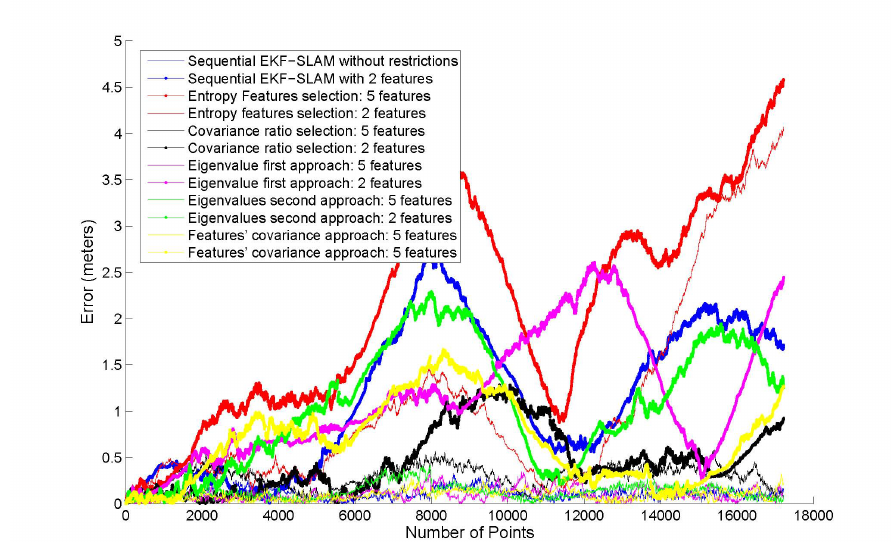
Figure 10. Evolution of the error of the different estimated paths by the EKF-SLAM algorithms proposed herein with respect to the predefined path. As it can be seen, the path estimated by the EKF-SLAM with the feature selection approach based on the covariance ratio shows the closest path to the one estimated by the full sequential EKF-SLAM. The path estimated by the entropy approach shows the worst path (with the higher error evolution). The Number of points axis refers to the successively points of the path used for the calculation of the error.